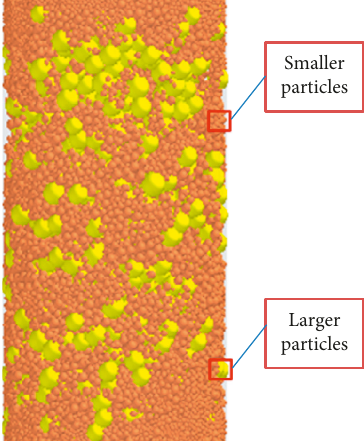
Figure 4: Particle model generated through